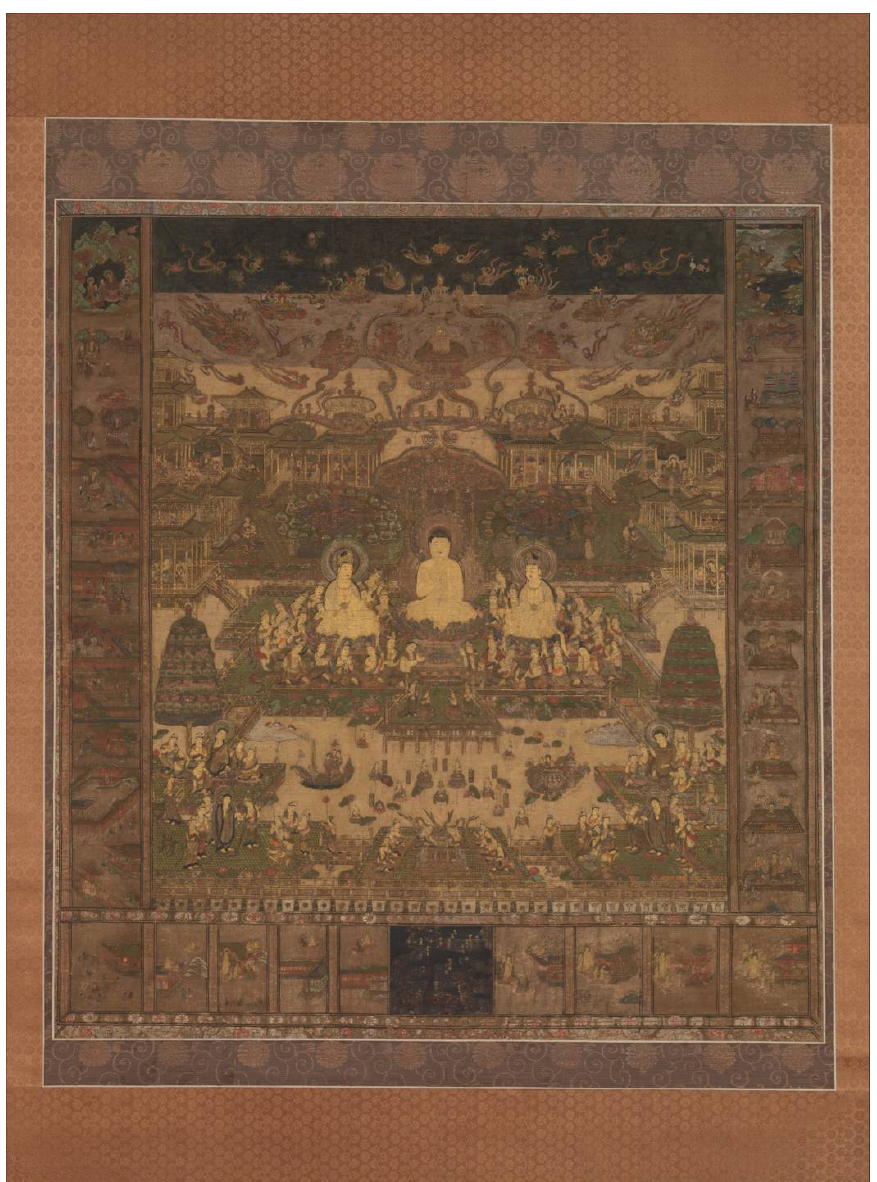
Figure 1. Taima mandala (mandara) (later reproduction), Late 14th century, Hanging Scroll; color and gold on silk, Height: 133.4 cm, Width: 121.9 cm, The Metropolitan Museum of Art (artwork in the public domain). Source: The Metropolitan Museum of Art, published under fair use.